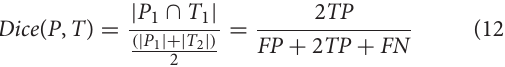
FIGURE 7 | The process of data pre-processing.